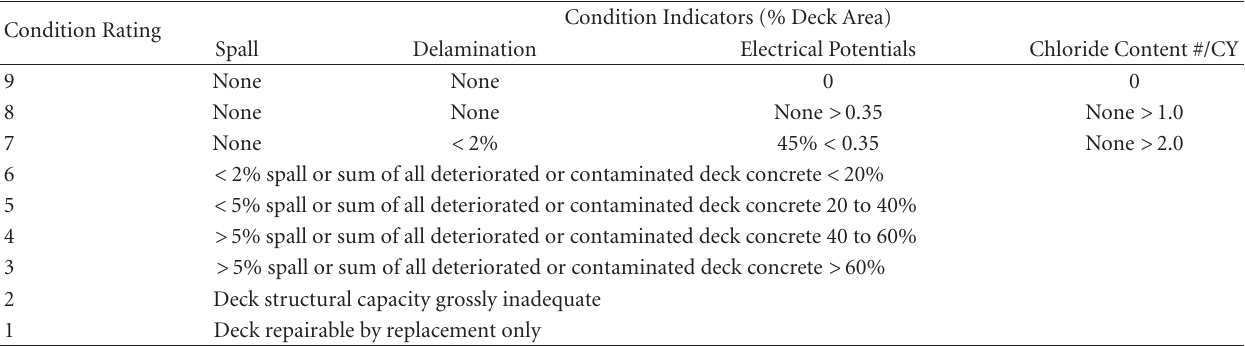
Table 1: FHWA’s concrete bridge deck condition rating